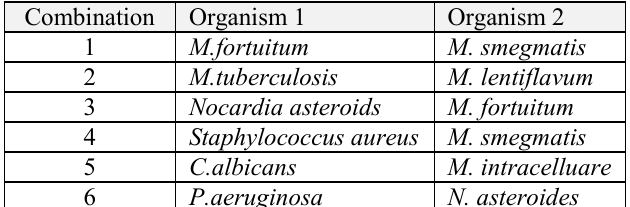
Table 4: Test Organism Combinations Combination Organism